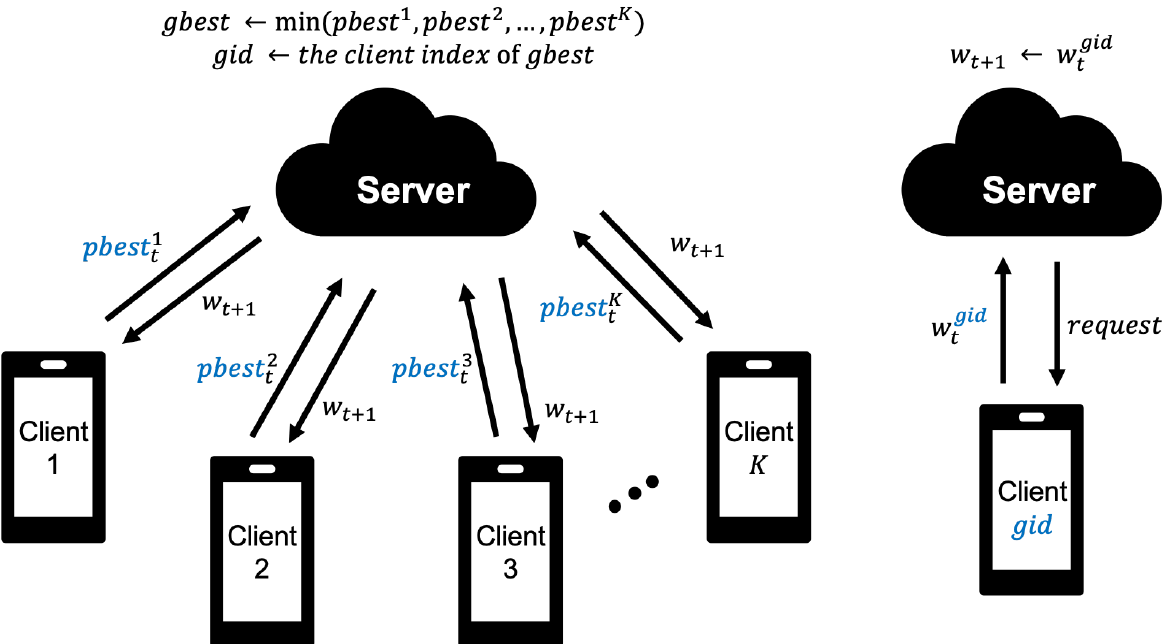
Figure 3. The weight update process of FedPSO ; the server receives a client’s score and requests a learning model from the client who submits the optimal value to set it as a global